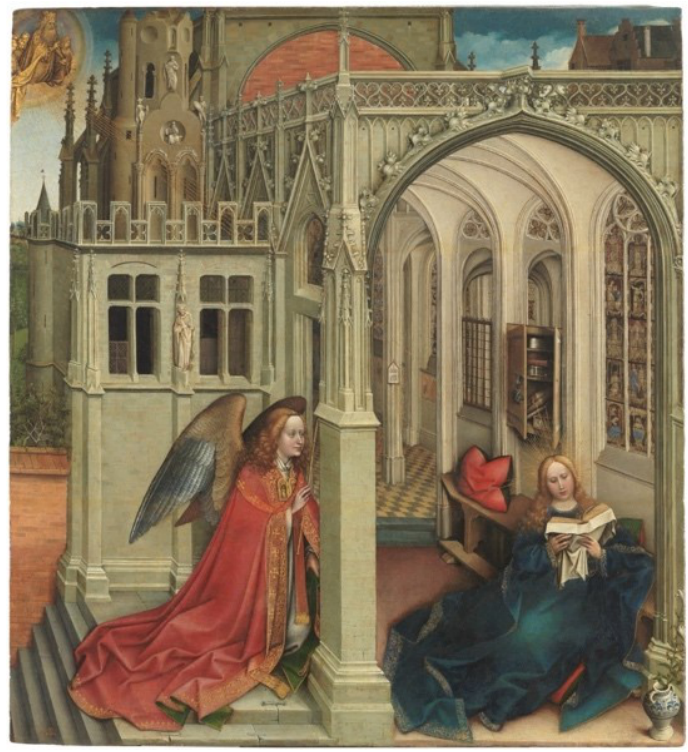
Figure 8. Robert Campin, The Annunciation , c. 1420–25. Prado Museum, Madrid.